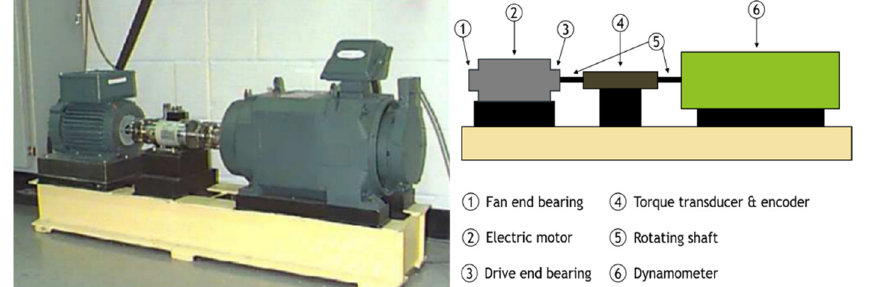
Figure 3. Photo ( left ) and schematic diagram ( right ) of the experimental device at Case Western Reserve University to assess bearing failure [44].